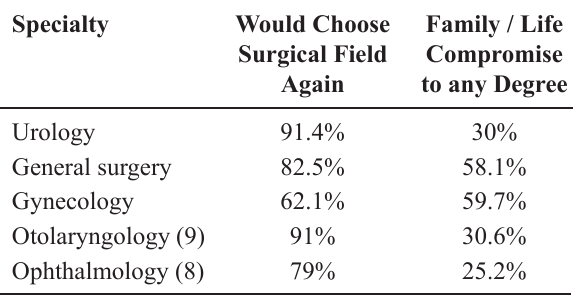
Table 4 – Comparison of specialty groups.